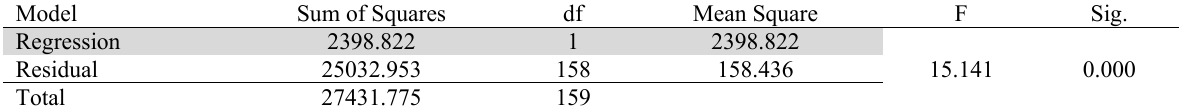
ANOVA leadership and performance